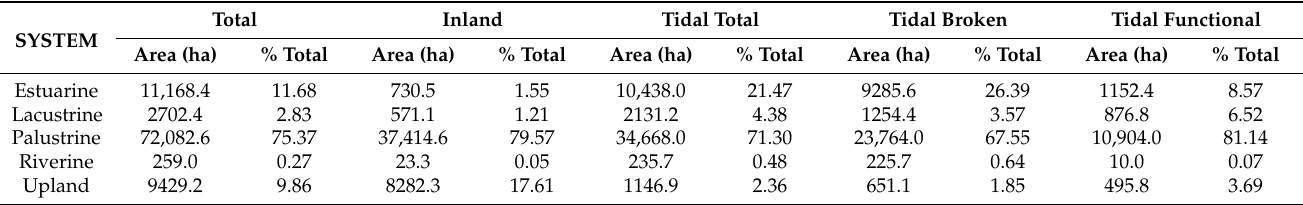
Table 2. Distribution of historic rice fields within the various system categories of the National Wetlands Inventory. SYSTEM